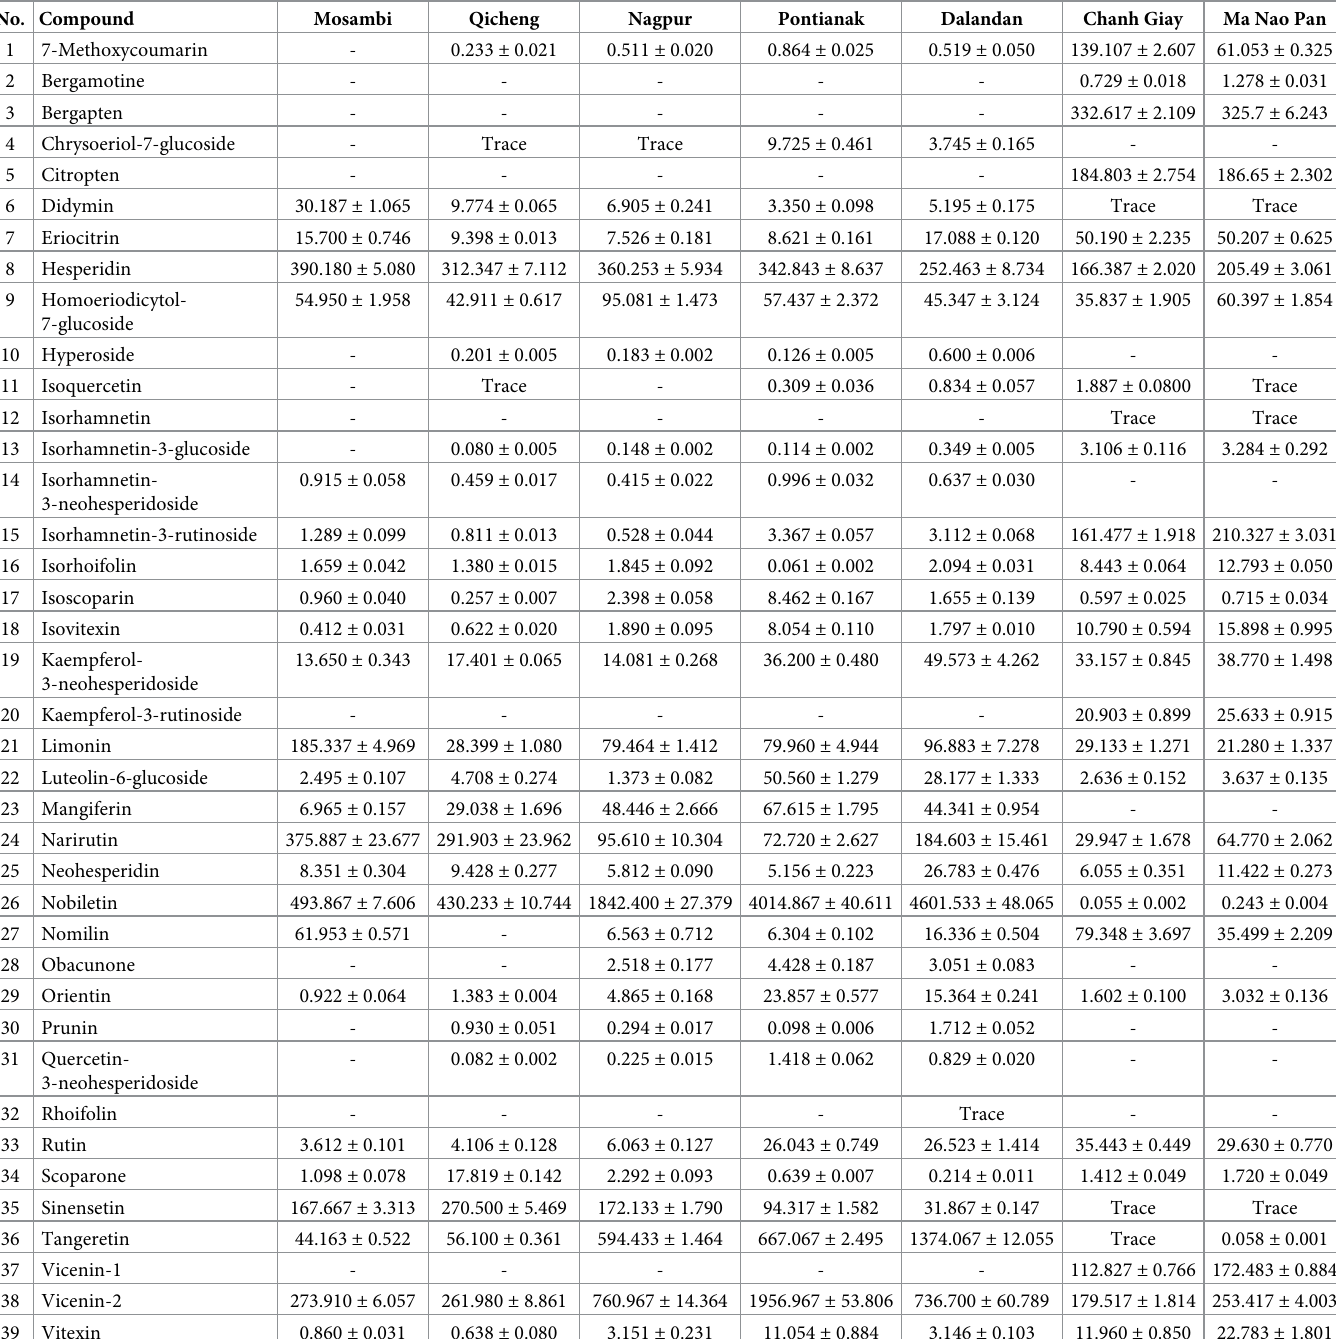
Table 1. Flavonoids, limonoids and coumarin compounds in citrus peel identified and quantified by LC-QTOF/MS (concentrations expressed in μ